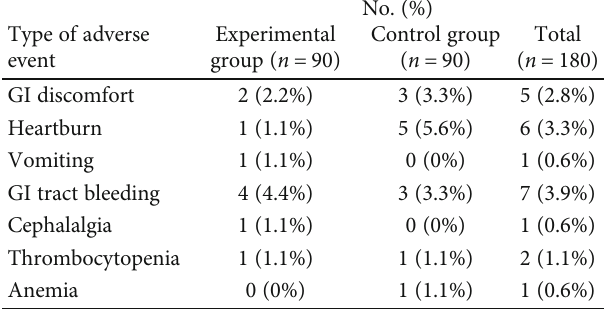
Table 6: Type of adverse